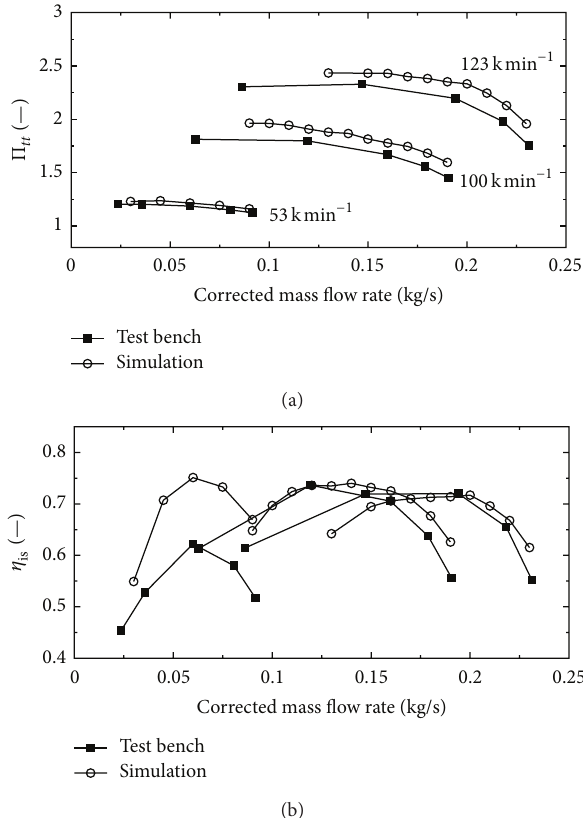
Figure 10: Total pressure ratio Π 𝑡𝑡 and isentropic efficiency 𝜂 is for the simulation and test bench measurements.